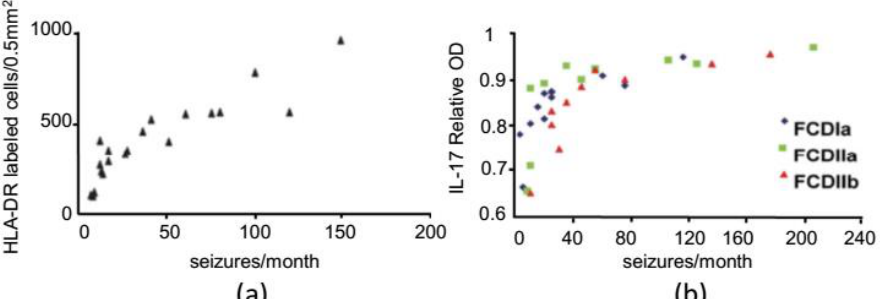
Figure 2. Correlation between inflammatory pathways and frequency of seizures in two exemplificative studies done in FCD patients. ( a ) Positive correlation between the distribution of cells of the activated microglia/macrophage lineage (HLA-DR positive cells) and frequency of seizures (replotted with permission from [35]). ( b ) Positive correlation between IL-17 positive cells and frequency of seizures in three different types of FCD (IL-17 relative optical density is expressed in y-axis; replotted with permission from [39]).